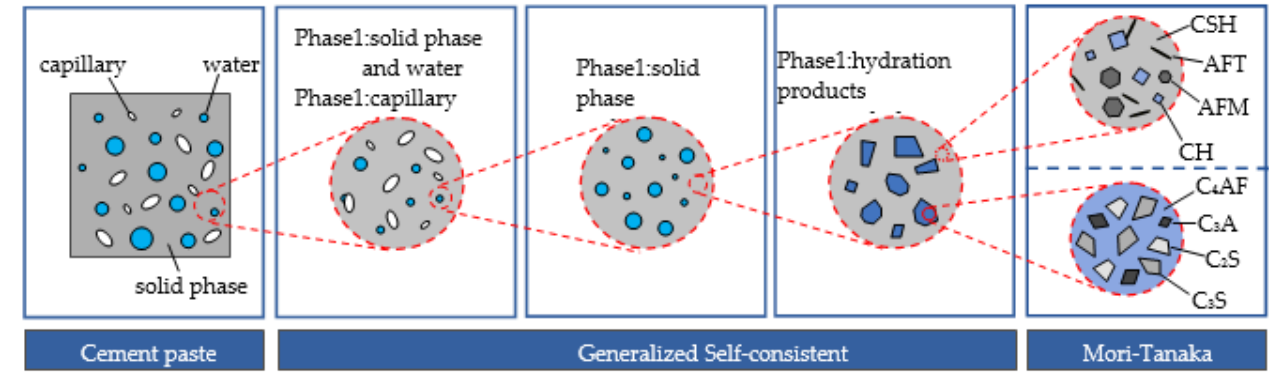
Figure 3. Multiphase modeling of cement paste.